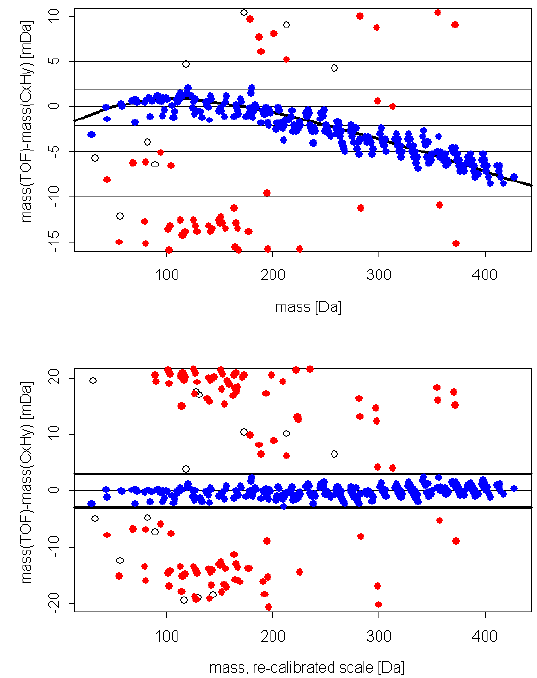
Fig. E1. Re-calibration of the mass scale. (a) shows the differ- Figure E1. Re-calibration of the mass scale. Panel ‘a’ shows the difference between the ence between the detected mass and the best match with the mass detected mass and the best match with the mass of a pure hydrocarbon. The peaks printed in of a pure hydrocarbon. The peaks printed in blue identified hy- blue identified hydrocarbon peaks (also see Figure 3); peaks printed in red and black (open drocarbon peaks (also see Fig. 3); peaks printed in red and black (open cycles) were identified non-hydrocarbon peaks and unidenti- cycles) were identified non-hydrocarbon peaks and unidentified peaks, respectively. The spline fied peaks, respectively. The spline function through the points was function through the points was used to re-calibrate the mass scale. Panel ‘b’ shows the same used to re-calibrate the mass scale. Panel (b) shows the same for for the re-calibrated mass scale. The accuracy of the detected masses is better than ±3 mDa the re-calibrated mass scale. The accuracy of the detected masses is (bold lines in panel b). better than ± 3mDa (bold lines in